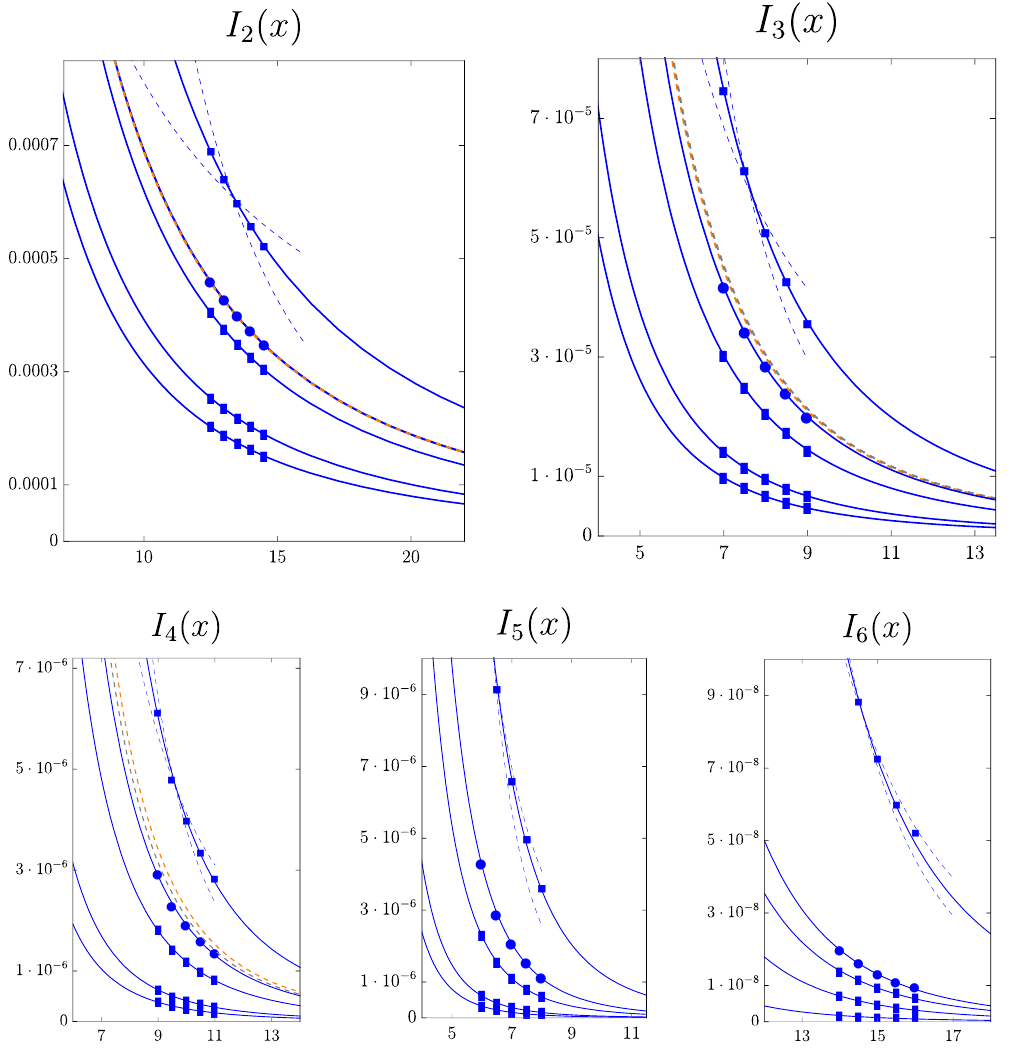
Figure 10 . For a free scalar in the lattice, we plot the I N (continuum values) for N = 2 , 3 , 4 , 5 , 6 for sets of: squares, disks, L × 2 L rectangles, L × 4 L rectangles and L × 6 L rectangles (in each plot moving from the uppermost curve to the bottom one) placed in a regular N -gon configuration. The horizontal axis is x = r/R , where r is the separation between the blocks and R their characteristic size (see previous section for more details on these definitions from the geometric setup). The solid curves correspond to fits of the form eq. (4.12), including two terms. The orange dashed lines in the √ I 2 , I 3 and I 4 plots correspond to curves (1 / 12) / ( x +1) 2 , 1 / (12 3 π ) · (1 /x 3 ) and (1 / 180+1 / (6 π 2 )) /x 4 respectively, which are the exact leading behaviours. In the last two cases, the subleading term (unknown) has a non-negligible effect, which explains the discrepancy with the points and the numerical fits (the dashed gray lines represent the leading terms in the numerical approximations which include two terms, namely: 0 . 0832 / ( x + 1) 2 , 0 . 0155 /x 3 and 0 . 0207 /x 4